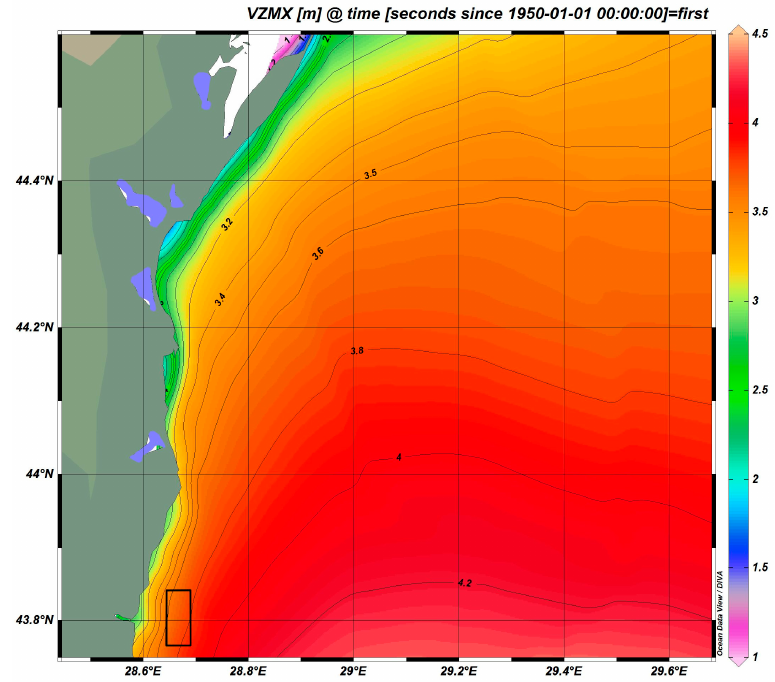
Figure 5. Maximum wave height (extreme swell) in the Mangalia area, Romania.